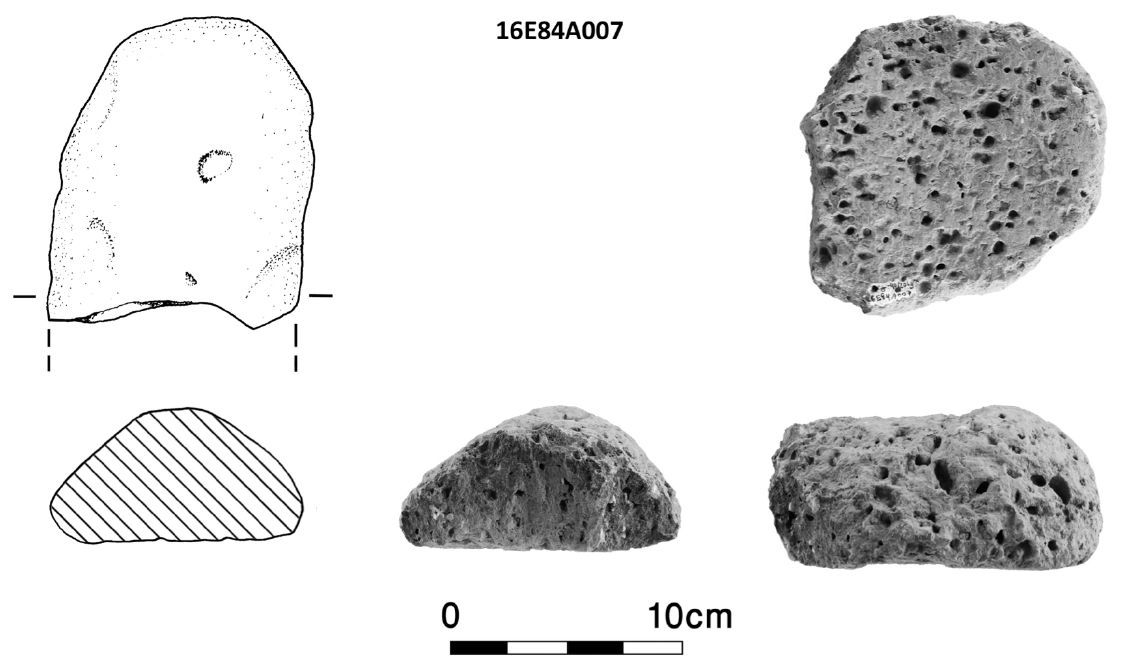
Figure 4. Illustration and picture of unifacial loaf